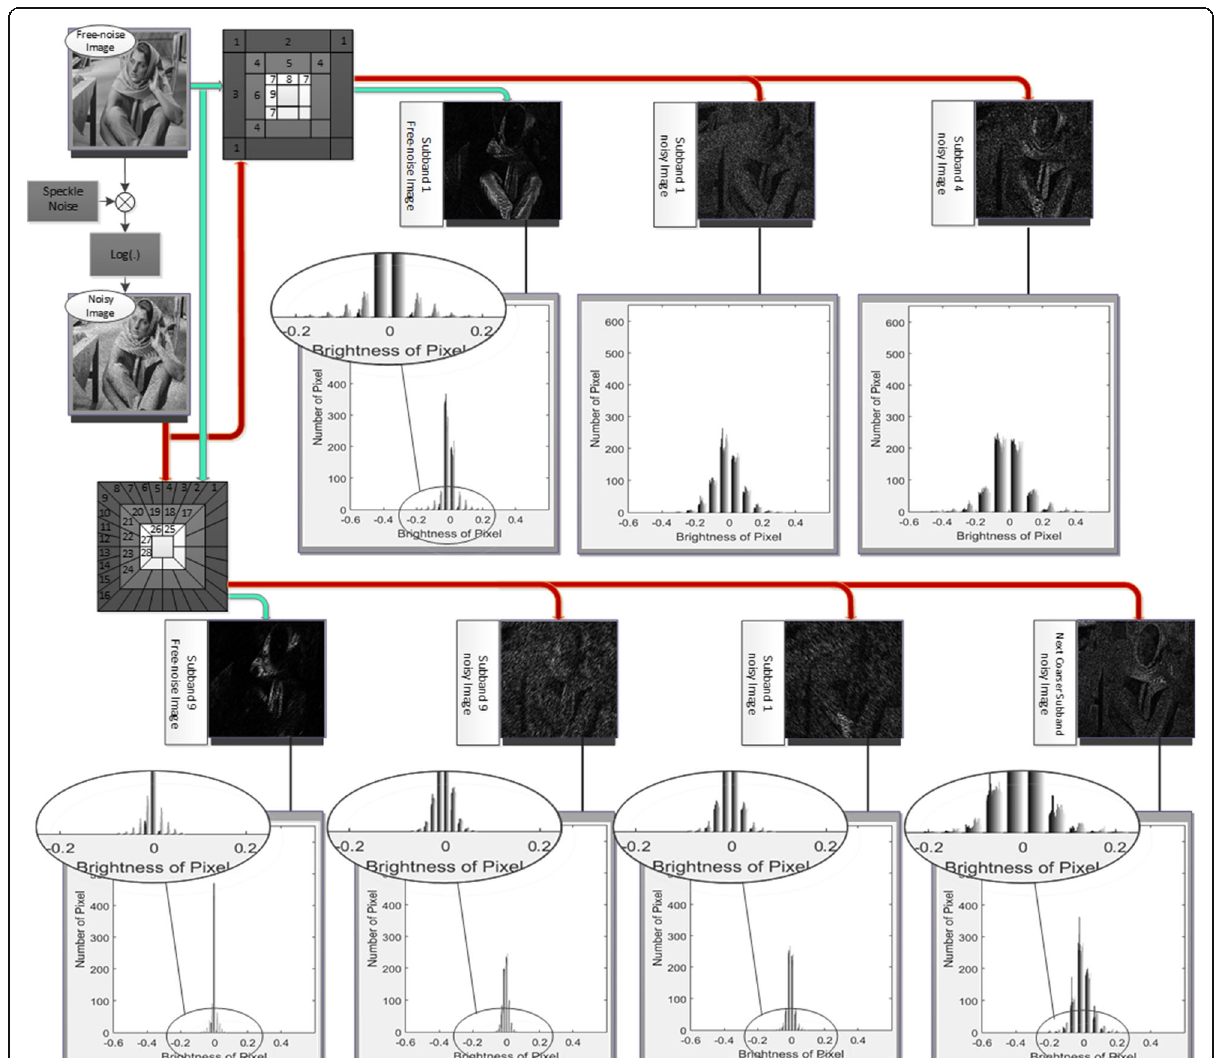
Fig. 3 Histogram for noise-free and noisy ( σ N 2 = 0.05) coefficients in SWT and NSST